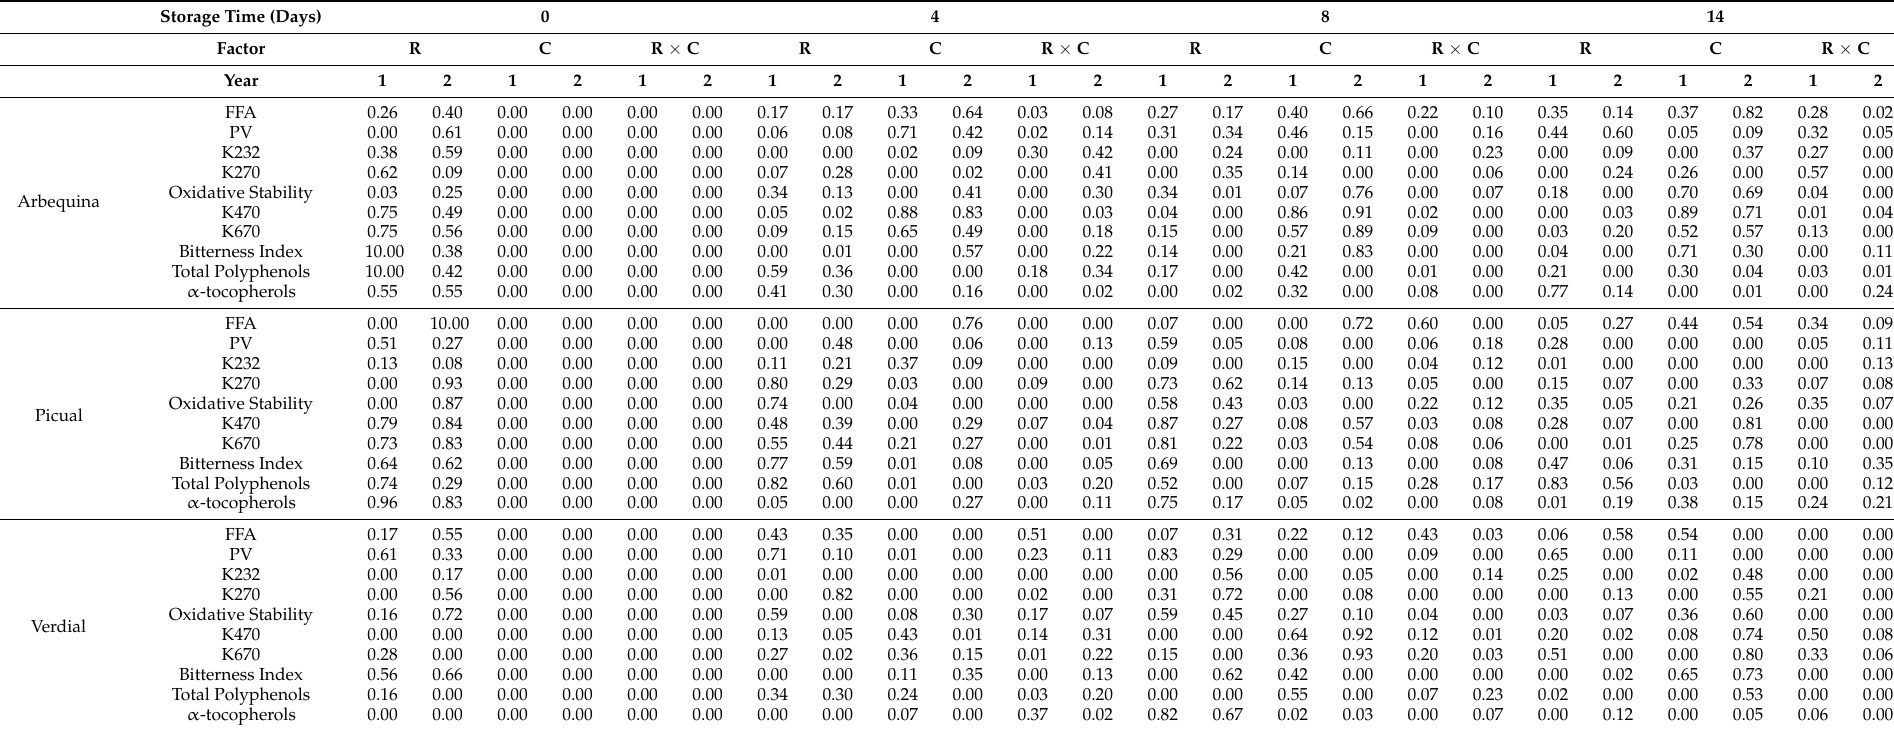
Table 1. Values of ˆ ω 2 as a measure of the effect of the factor harvesting (R), conservation (C), and the interaction between both (R × C), for each of the 4 storage times during year 1 and 2. Negative values are set to